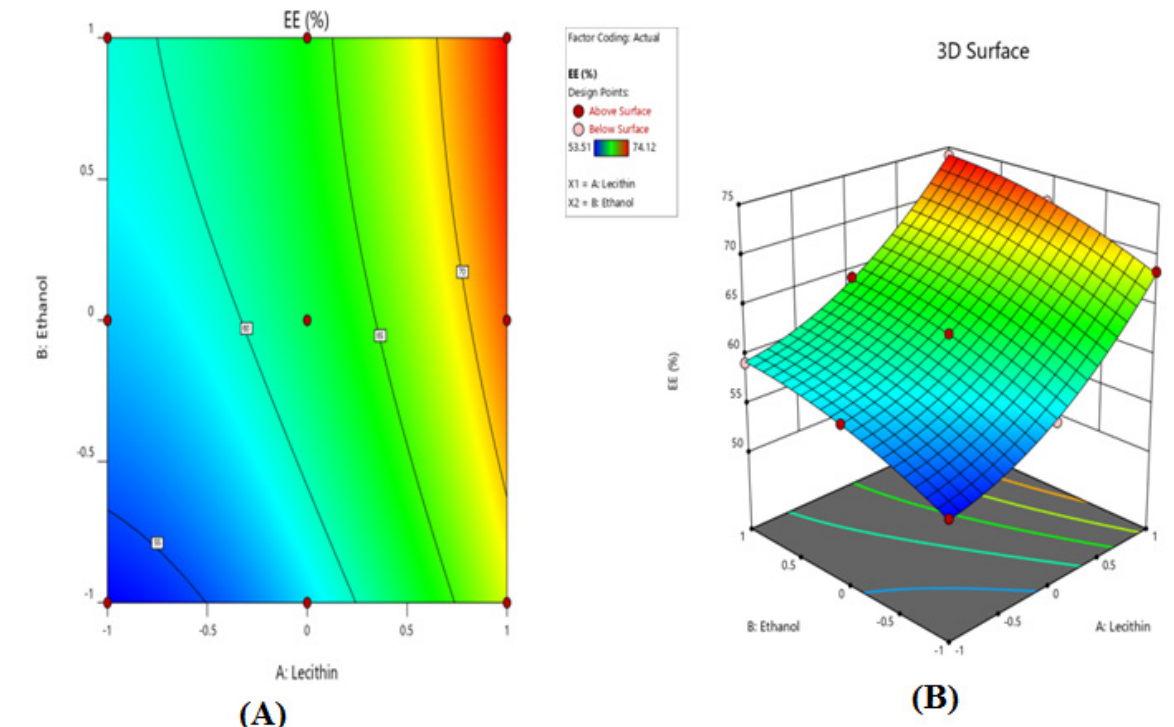
Figure 2. 2D contour plots ( A ) and 3D response surface plots ( B ) for evaluating the influence of lecithin ( X 1) and ethanol ( X 2) on entrapment efficiency ( Y 2).